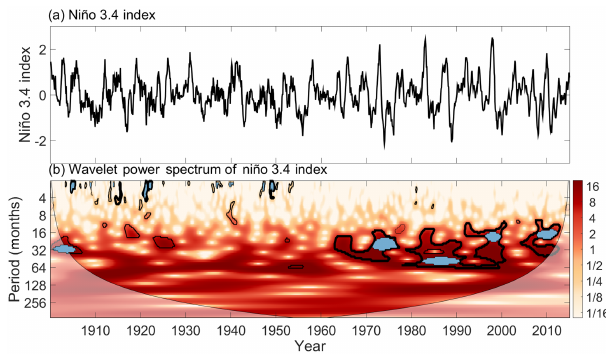
Figure 1. Wavelet power spectra of the Niño 3.4 index. Thin black contours enclose regions of 5% pointwise significance and thick contours indicate those patches that are geometrically significant at the 5% level. Light blue shading represents 5% areawise significant subsets of the patches. Light shading represents cone of influence, the region in which edge effects cannot be